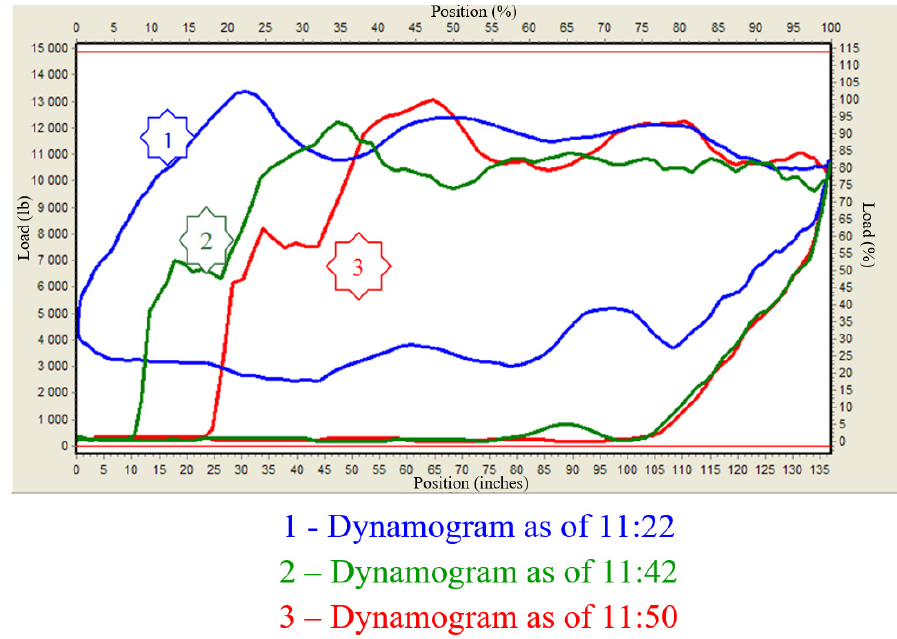
Figure 7. Sucker-rod string floating chart after annular gas extraction.